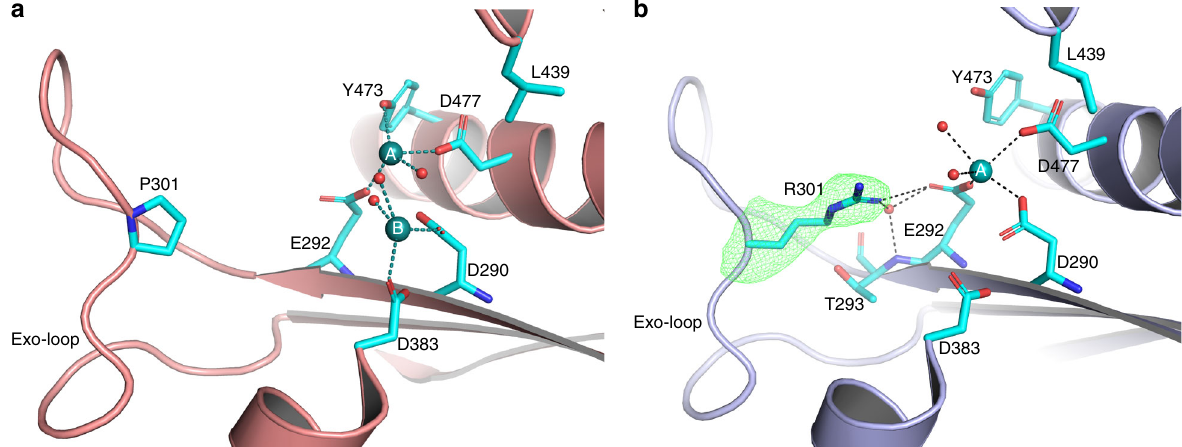
Fig. 2 The wild-type and P301R exonuclease active site of Pol ε . a The crystal structure of Pol2 CORE -M644G showing the active site of the wild-type exonuclease domain (shown in salmon) with two metals (in dark cyan) and the Exo-loop with P301. Residues mentioned in the main text are shown in cyan. b The structure of the exonuclease domain of Pol2 CORE -P301R (shown in light blue) showing the active site and the Exo-loop. The polder omit map calculated for R301 at 5 σ is shown as a green mesh. Residues mentioned in the main text are shown in cyan. The metal Ca 2 + , located in the A-site, is shown in dark